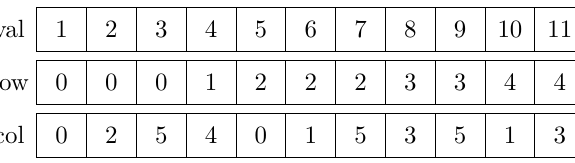
Figure 2. The coordinate storage (COO) representation of matrix A .